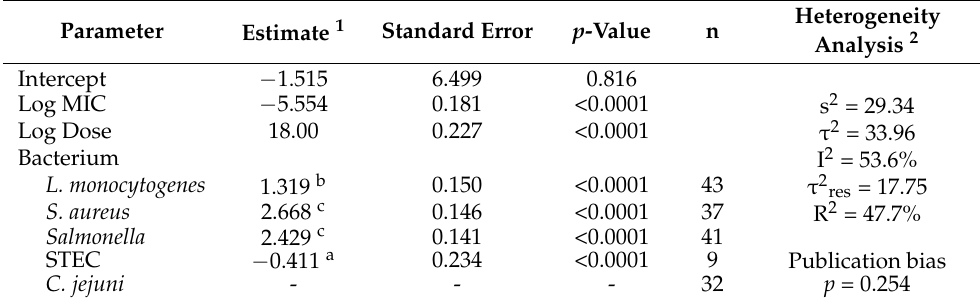
Table 7. Meta-regression analysis of the inhibitory diameter induced by extracts from Origanum ( n = 145), Syzygium aromaticum ( n = 10), and Citrus ( n = 7) plants, as a function of the MIC (mg/mL for extracts and µ L/mL for EOs), extract dose (%), and bacterium. Number of observations (n) per factor level, heterogeneity analysis, and p -value of the publication bias test are